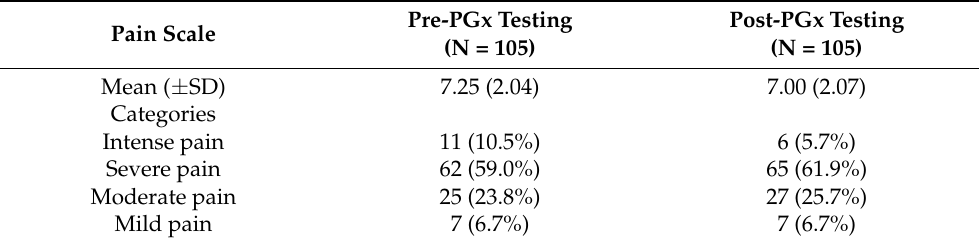
Table 5. Patients’ pain scale pre- and post-pharmacogenomic (PGx) testing.